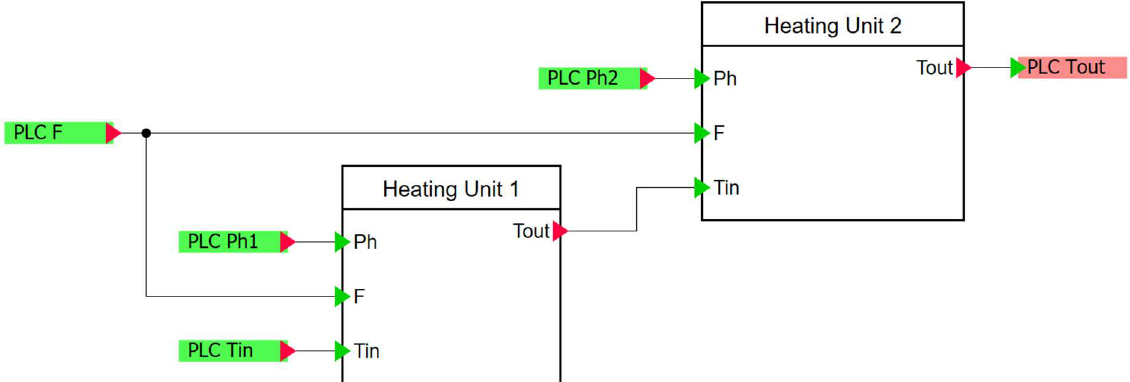
Figure 5. Schematic diagram of the simulator of the double-heater HS implemented in SIEMENS ® Simit v10.3 industrial software as the connection of two separated HU.